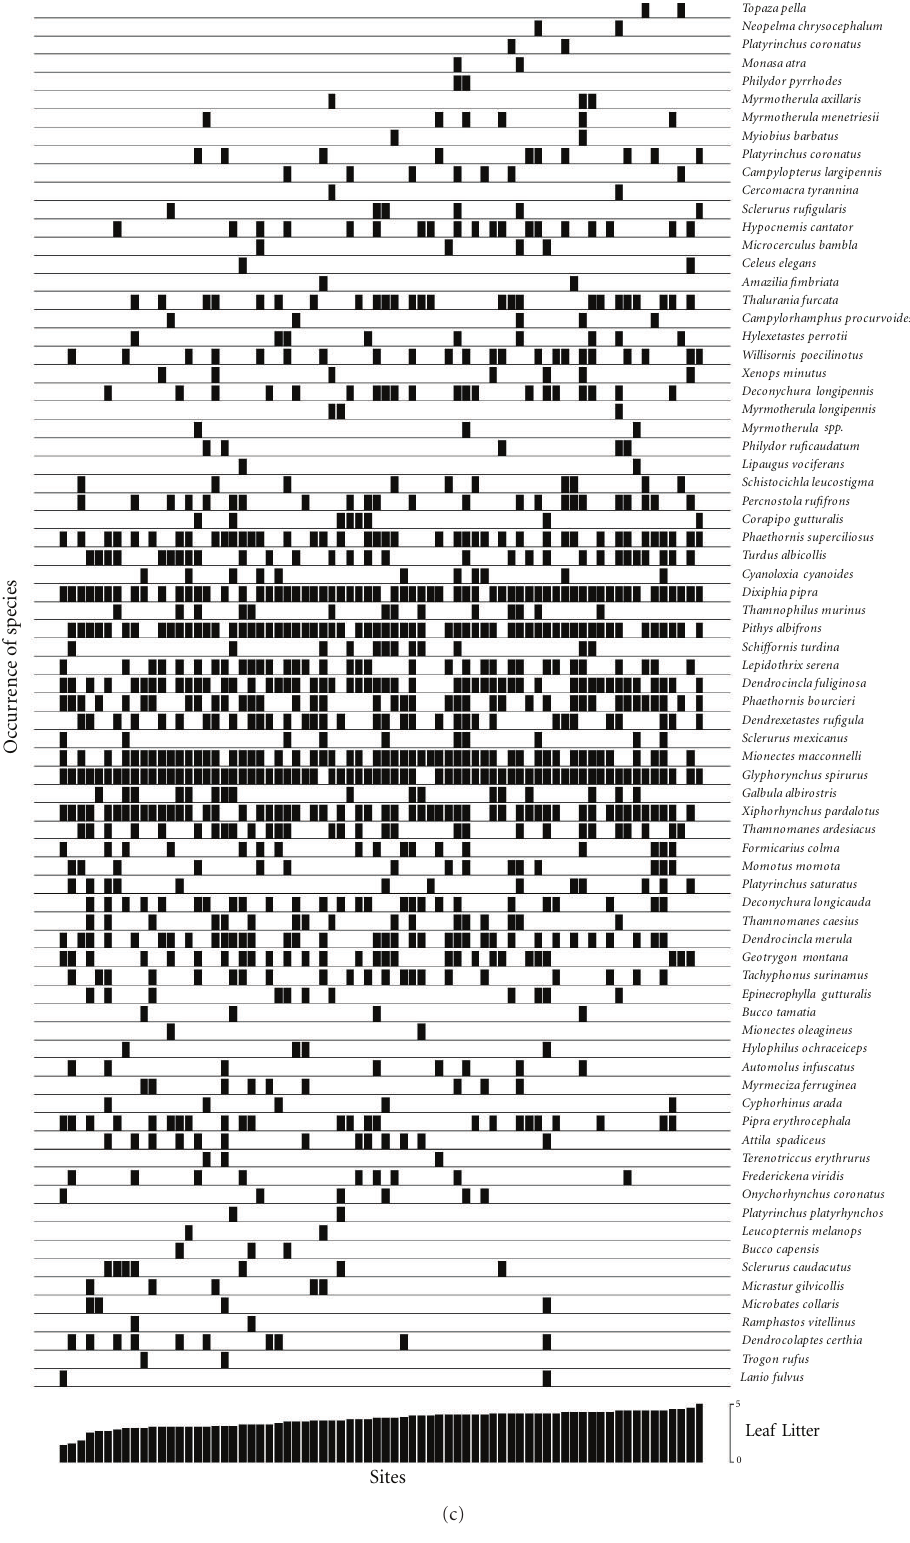
Figure 3: Bird species captured in 72 lines of mist-nets at Reserva Florestal Adolpho Ducke, near Manaus, Brazil, in relation to gradients in (a) elevation, (b) distance to the nearest stream, and (c) leaf litter depth. Species bars represent the presence of each species in a given line (presence/absence qualitative data), whereas height of bar at the bottom represents the quantitative value of those